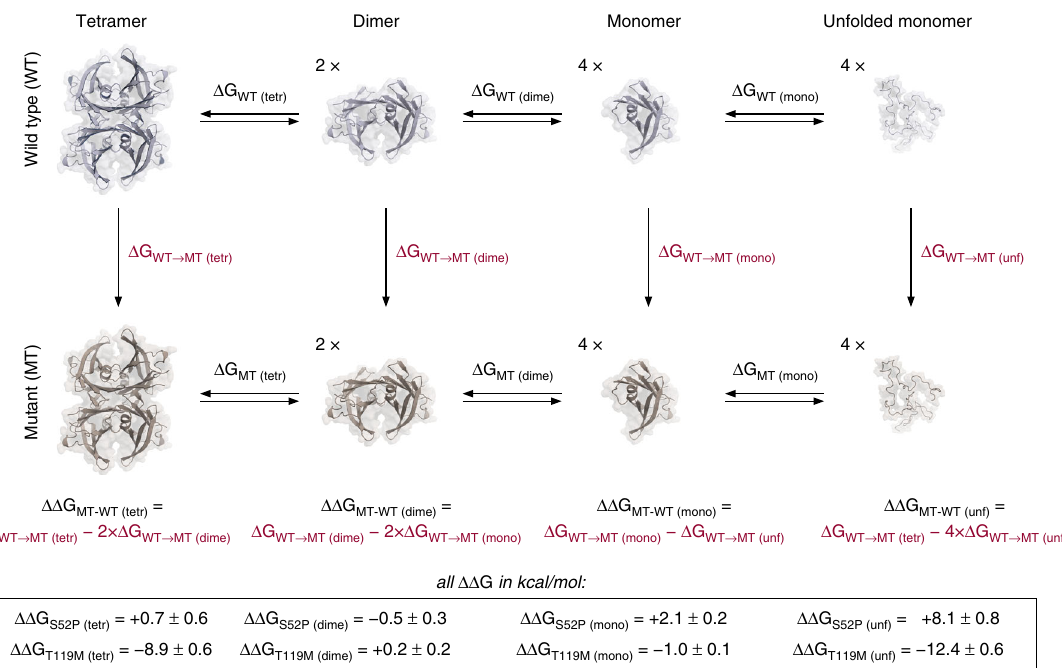
Fig. 2 Relative stability of mutant tetramers, dimers, and monomers, with respect to WT-TTR. ΔΔ G (tetr) is the stability of the mutant tetramers with respect to WT-TTR for the process of dissociation to dimers; ΔΔ G (dime) represents the relative stability of the mutant dimers when they dissociate to monomers; ΔΔ G (mono) indicates the relative stability of the mutant monomers for unfolding; ΔΔ G (unf) is the relative stability of the mutant tetramers for the overall processes of tetramer dissociation and unfolding. The uncertainties shown are one standard error of the mean, obtained from ten repeated